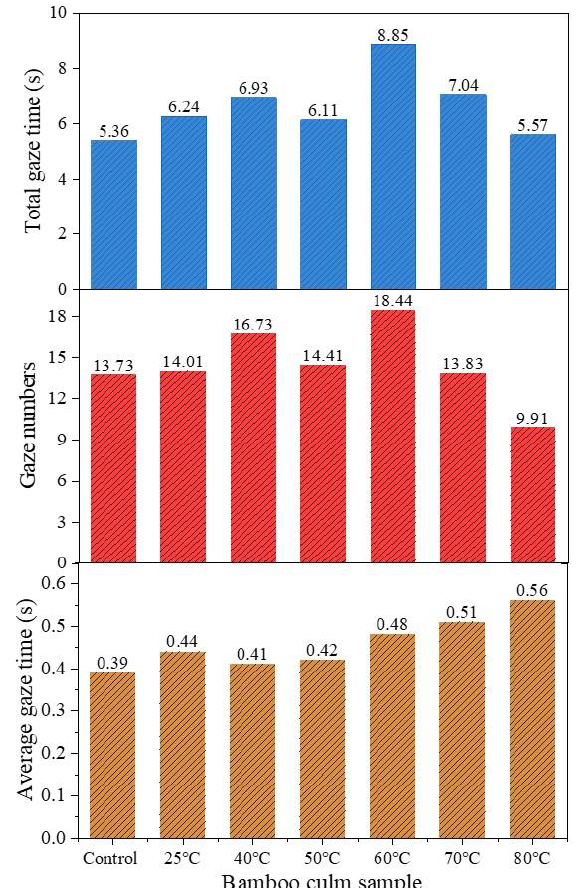
Figure 6. The total gaze time, gaze numbers, and average gaze time of bamboo culms. The heat map showed the overall effect of all the gaze points on the samples [53]. The visual intensity mapped here reflects the degree of preference for each treatment at each temperature. The gaze frequency and time are represented using a color gradient between green-yellow-orange-red. Green represents a lower gaze frequency and shorter gaze time, while red represents a higher gaze frequency and longer gaze time. Figure 7 intuitively shows the gaze regions and visual presentation. From the heat map, the gaze point con- centration area is distributed between the 60 °C and 40 °C treatments. The control group and bamboo treated with 70 °C and 80 °C have fewer gaze points. Considering the three factors of color, gloss and texture, the light color, appropriate gloss and sparse stripes may attract the most attention of all the bamboo culms. On the contrary, dark color, high gloss, and dense, uneven stripes attract less attention. The lower lightness and uneven texture at 80 °C received very little attention. Similarly, the bamboo culm treated at 50 °C with lower lightness and higher gloss obtained less attention than the culm treated at 40 °C.